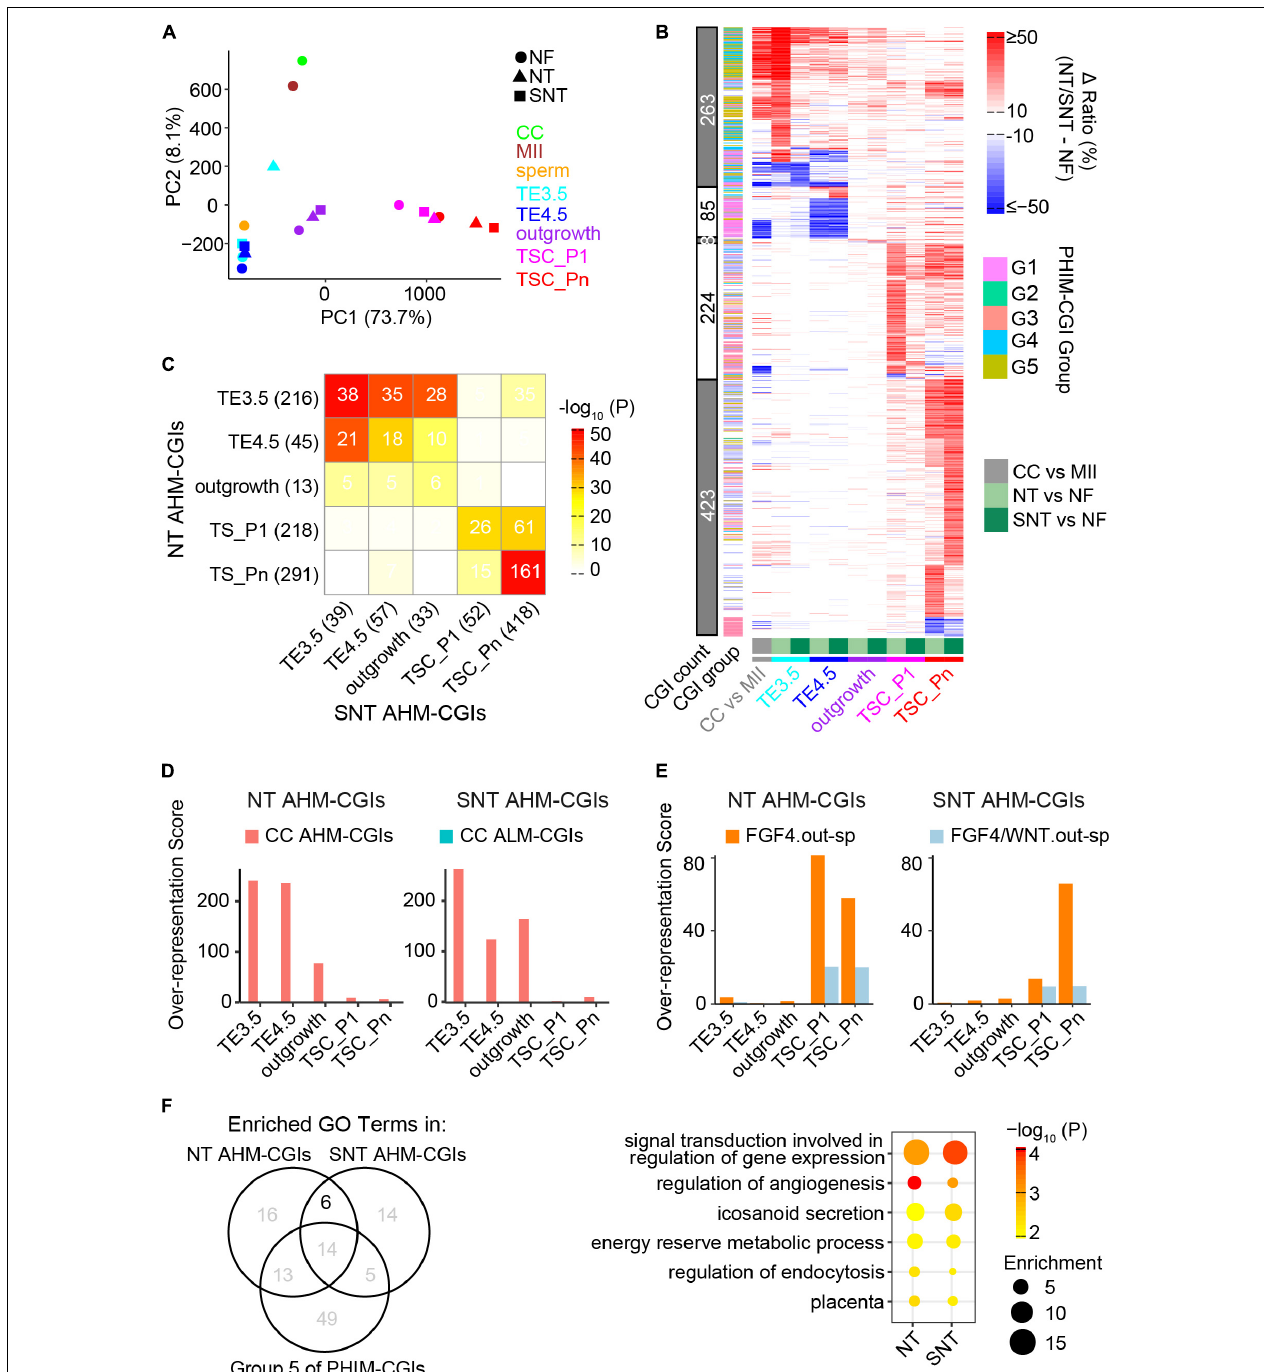
FIGURE 5 | Abnormal methylation in the donor genome is a barrier to methylation remodeling during NT TSC derivation. (A) PCA results of CGI methylation during NF, NT, and SNT TSC derivation. CC (cumulus cell), MII oocyte, and sperm are also included for comparison. Their methylation data are from GSE56697 (Wang et al., 2014). (B) A heat map showing methylation difference of aberrantly highly methylated (AHM)- and aberrantly lowly methylated (ALM)-CGIs (Definitions are in section “Results”). (C) A heat map showing the intersection between NT and SNT AHM-CGIs. Filled colors indicate the significance of the intersection (hypergeometric test). Numbers indicate CGI count. (D) CC AHM-CGIs are enriched in early stages (TE3.5, TE4.5, and outgrowth) of NT/SNT TSC derivation. (E) “FGF4.out-sp” CGIs are specifically enriched in AHM-CGIs of NT and SNT TSC_P1, and TSC_Pn. “FGF4.out-sp” denotes the CGIs that are highly methylated in ICM treated with FGF4 but not in EXE and EPI. (F) Venn diagram showing the intersection the GO terms for which NT/SNT AHM-CGIs and the Group 5 of PHIM-CGIs ( Figure 4C ) are significantly enriched. The numbers indicate GO term count. The bubble plot showing the six GO terms specifically common to the GO terms for which NT/SNT AHM-CGIs are significantly